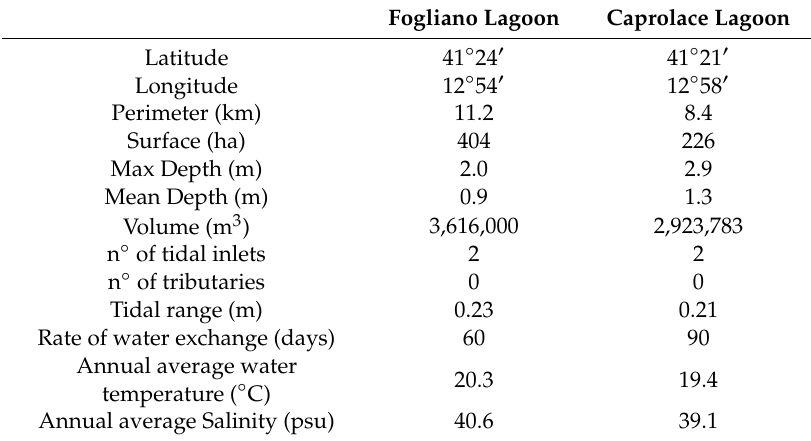
Table 1. Geo-morphological and hydrographic features of the two coastal lagoons of the Circeo National Park, Fogliano and Caprolace. Both lagoons fall in the category of non-tidal ( < 50 cm), euhaline lagoons (average 30 psu) of the Mediterranean ecoregion according to the classification of the transitional water under Directive 2000 / 60 EC